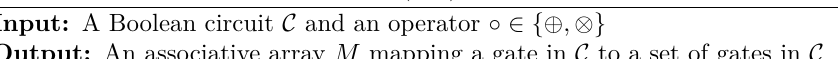
Algorithm 5 DetectCoOperands ( C , ◦